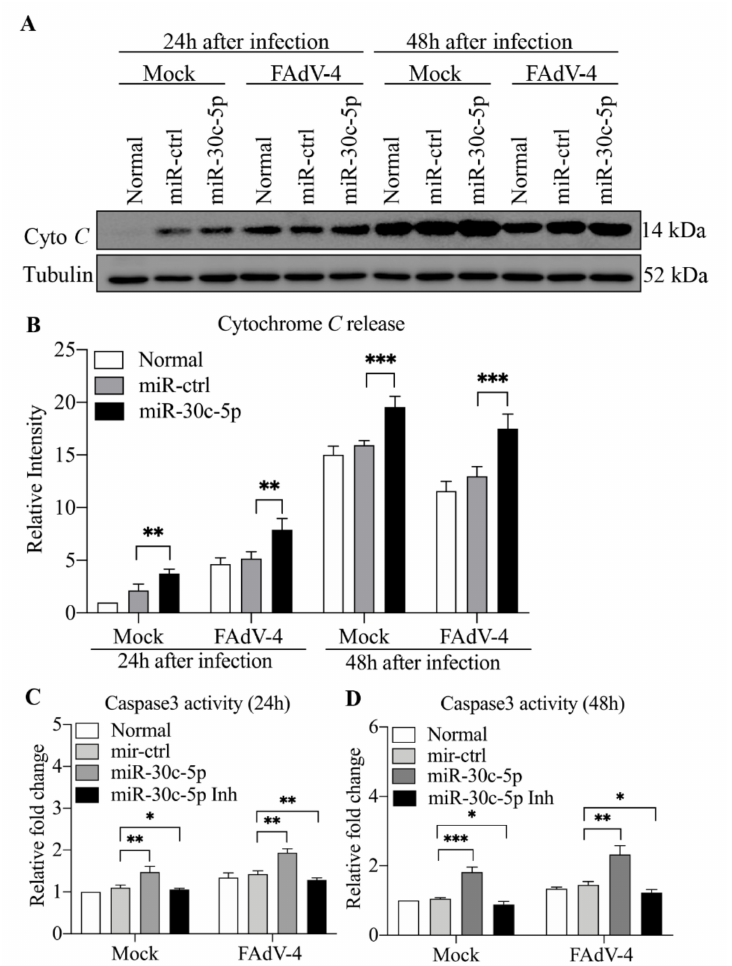
Figure 8. The transfection of cells with gga-miR-30c-5p enhanced FAdV-4-induced cytochrome c release and caspase-3 activation. ( A , B ) The transfection of cells with gga-miR-30c-5p enhanced the FAdV-4-induced release of cytochrome c . The LMH cells were transfected with the indicated miRNAs or miRNA controls. Twenty-four hours after transfection, the cells were mock-infected or infected with FAdV-4 at an MOI of 1. At the indicated time points (24 and 48 h) after FAdV-4 infection, cytosolic proteins were prepared and subjected to Western Blot analysis for the measurement of cytochrome c in the cytosol of cells. The band densities of cytochrome c in ( A ) were quantitated by densitometry. The relative levels of cytochrome c were calculated as follows: band density of cytochrome c /that of Tubulin. ( C , D ) The transfection of cells with gga-miR-30c-5p enhanced FAdV-4-induced activation of caspase-3. The LMH cells were treated as described above in ( A ). Twenty-four or 48 h after FAdV-4 infection, the activities of caspase-3 were measured at 405 nm with a microplate reader using the substrates DEVD-pNA (synthetic caspase-3 substrate). Data are representative of three independent experiments and presented as means ± SD. (*** stands for p < 0.001; ** for p < 0.01; * for p <